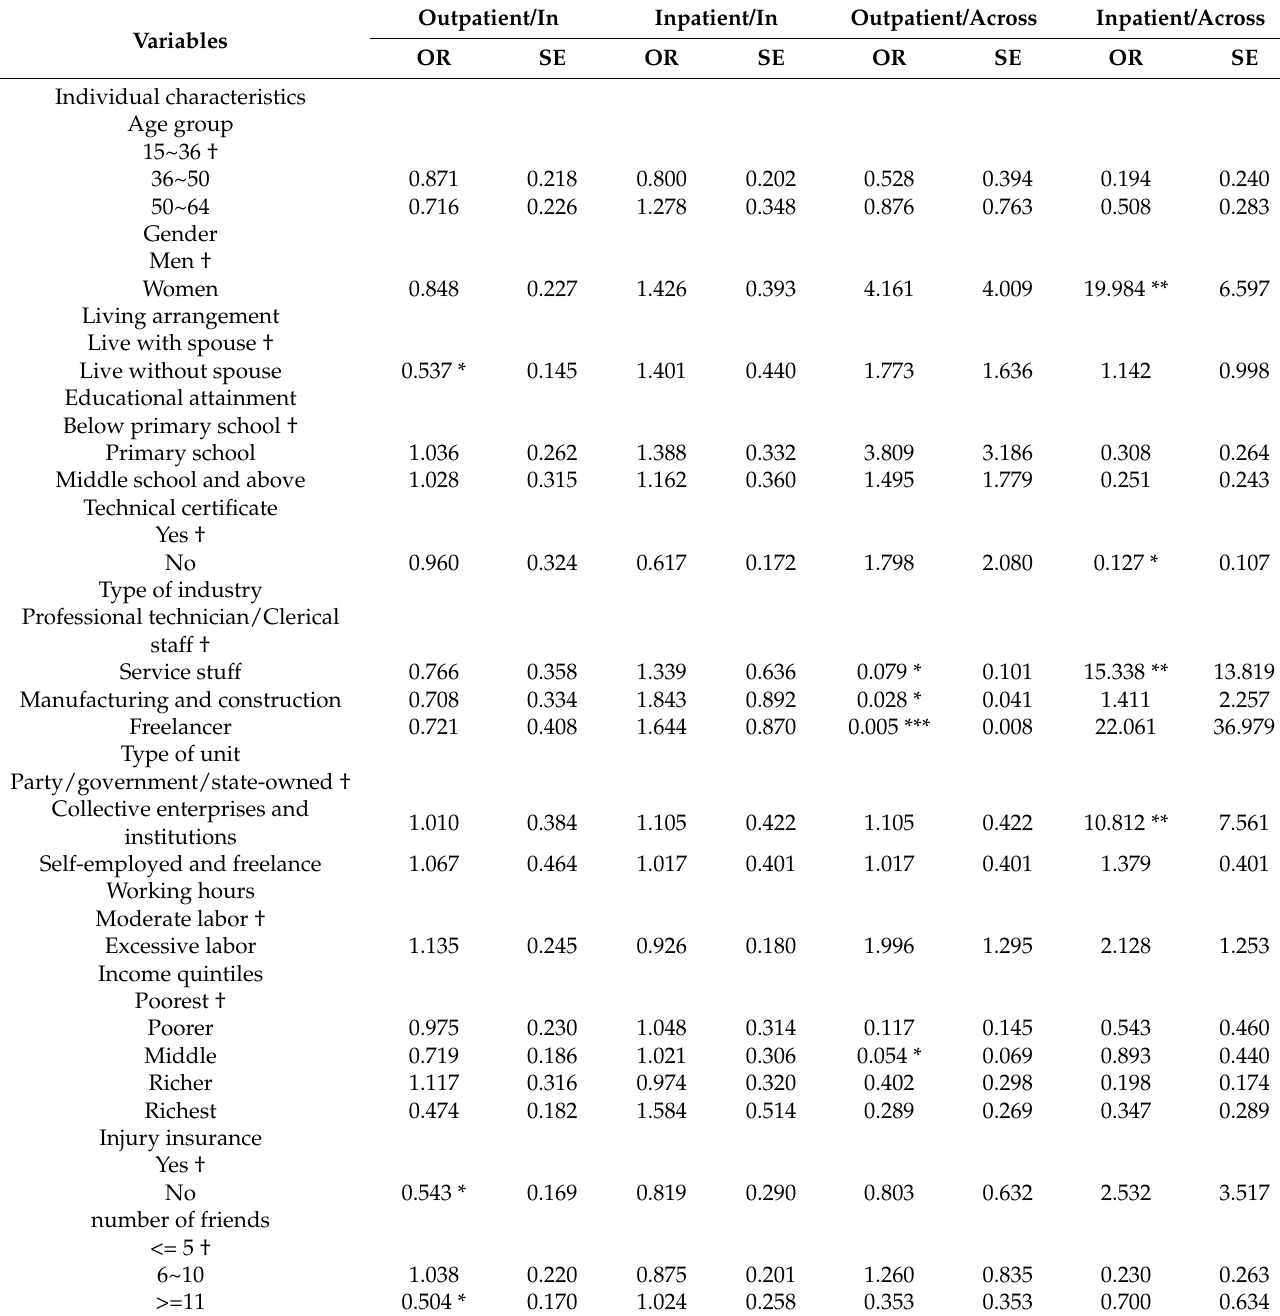
Table 4 presented the association of independent variables and health service utiliza- tion by multilevel regression models. The factors influencing the two-week outpatient utilization for rural migrant workers with NCMS in the county/district were marital status, injury insurance, number of friends, SAH and regular exercise every month; the factors influencing the inpatient utilization for rural migrant workers with NCMS in the county/district was SAH; the factors influencing the two-week outpatient utilization for rural migrant workers with NCMS across the county/district were occupational type, economic level, SAH and regular exercise per month; the factors influencing the inpatient utilization for rural migrant workers with NCMS across the county/district were gender, occupation, type of organization, exercise, and well-being. Table 4. Association of independent variables and health service